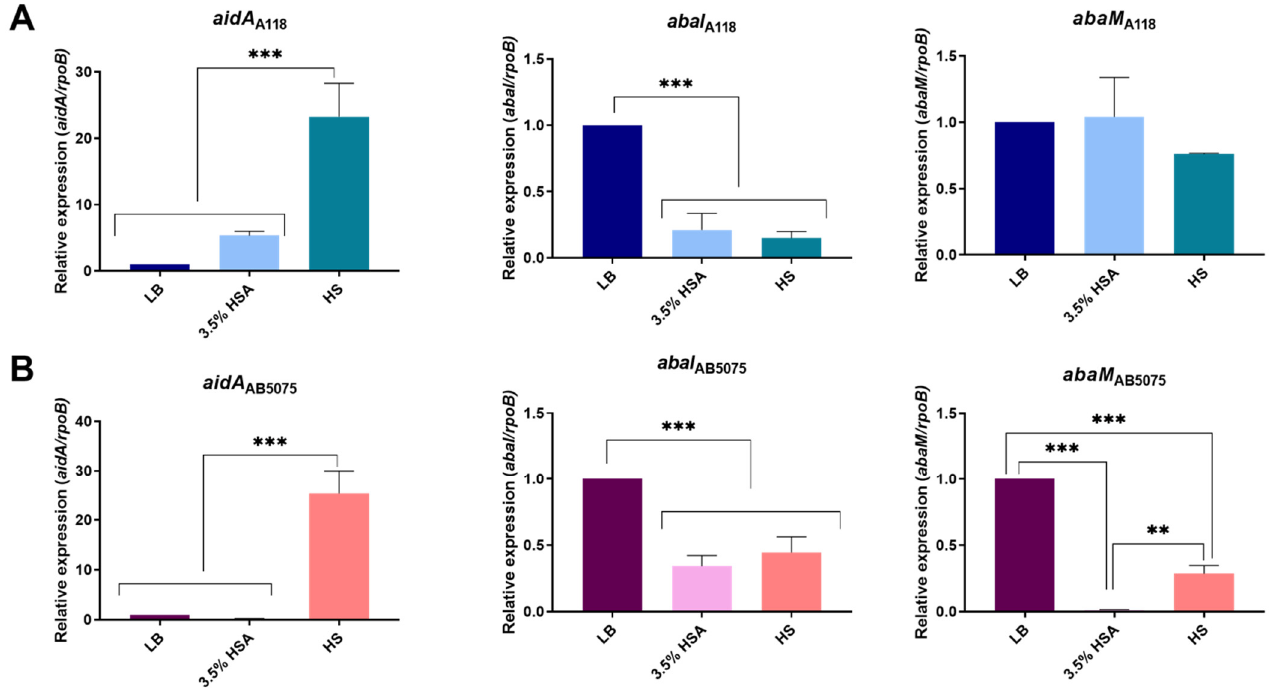
Figure 6. Effect of human serum albumin (HSA) and pooled normal human serum (HS) on the expression of quorum sensing genes in A. baumannii . qRT-PCR of A118 ( A ) and AB5075 ( B ) strains of the aidA , abaI, and abaM genes associated with quorum sensing and quorum quenching expressed in LB, LB supplemented with 3.5% HSA, or in HS. Fold changes were calculated using double ∆∆ Ct analysis. At least three independent samples were used. LB was employed as the reference condition. Statistical significance ( p < 0.05) was determined by ANOVA followed by Tukey’s multiple-comparison test, one asterisks: * p < 0.05; two asterisks: ** p < 0.01 and three asterisks: *** p < 0.001.